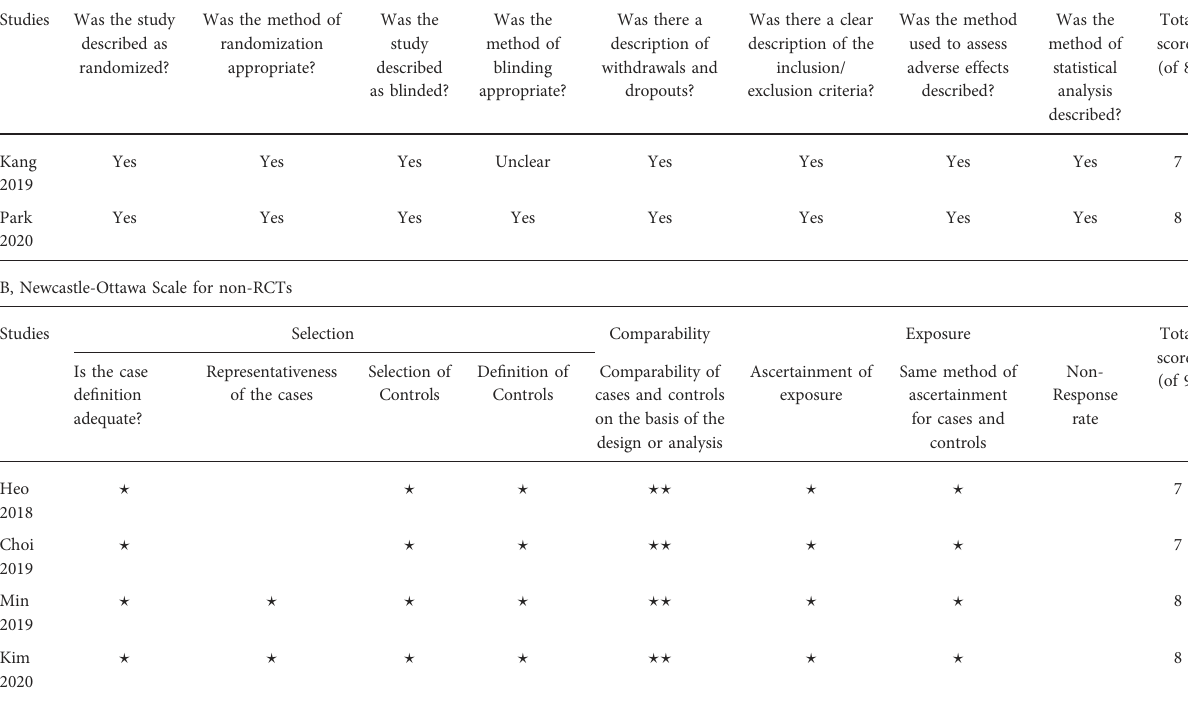
TABLE 1 Quality assessment of the included studies. A, Modi fi ed Jadad Scale for RCTs Studies Was the study described as